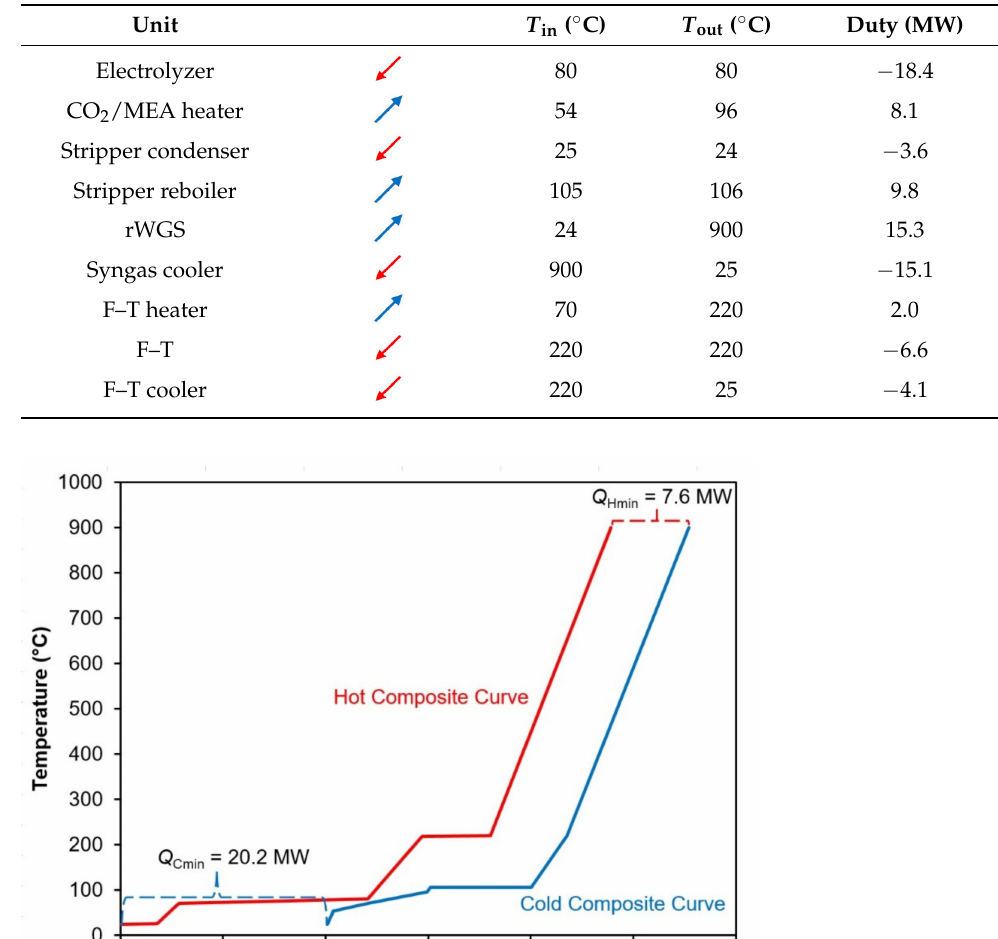
Table 3. Stream data of the BEJF process.